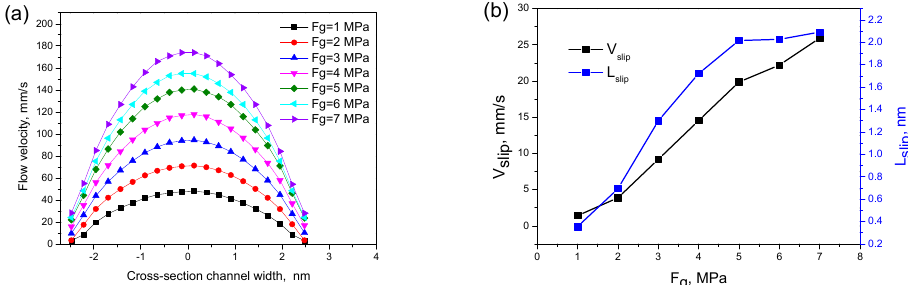
Figure 7. ( a ) Flow velocity curves under different external pressures; ( b ) wall slip speed and length under different external pressures.